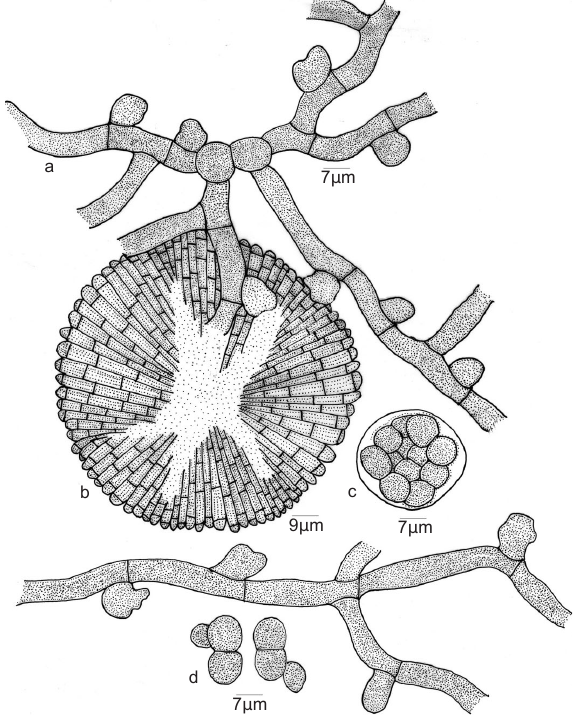
Figure 1. Bheemamyces argyreicola sp. nov. a - Appressoriate mycelium; b - Thyriothecium; c - Ascus; d - Ascospores